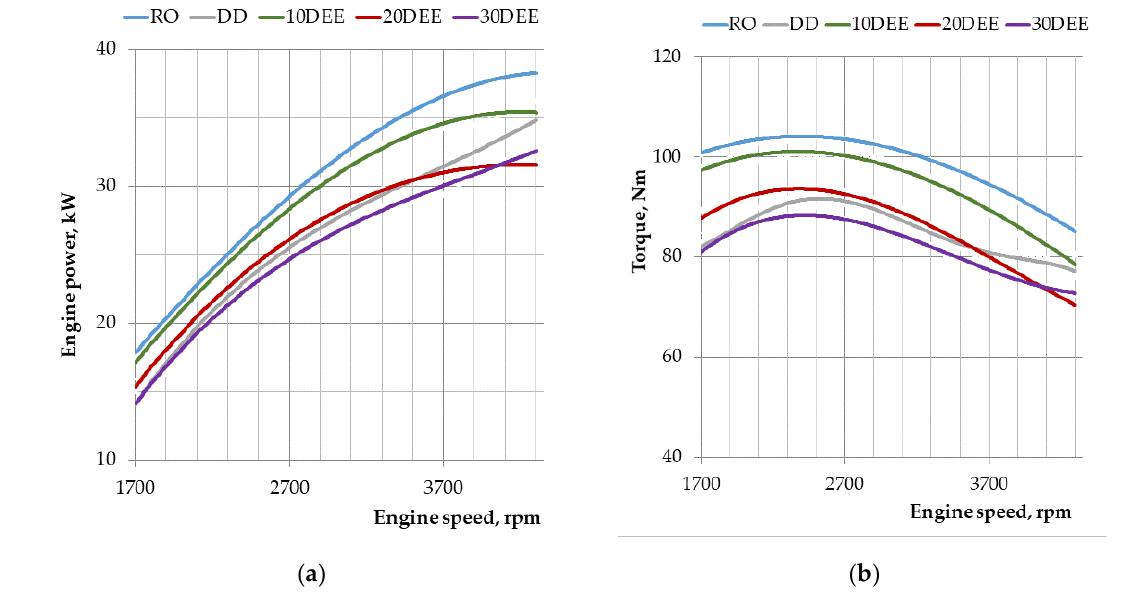
Figure 3. ( a ) Engine power and ( b ) torque curves for different fuels and blends.